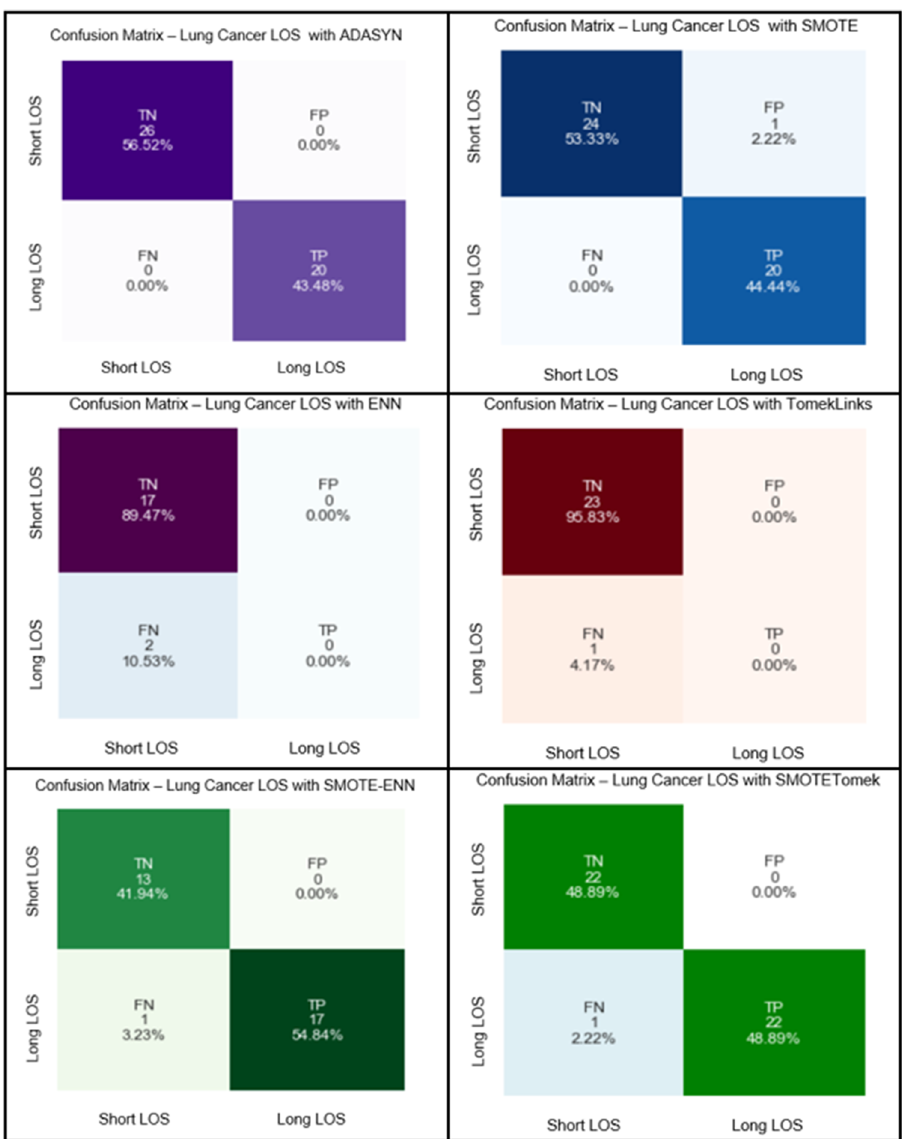
Figure 1. Confusion matrix for class-balancing techniques for lung cancer LOS with